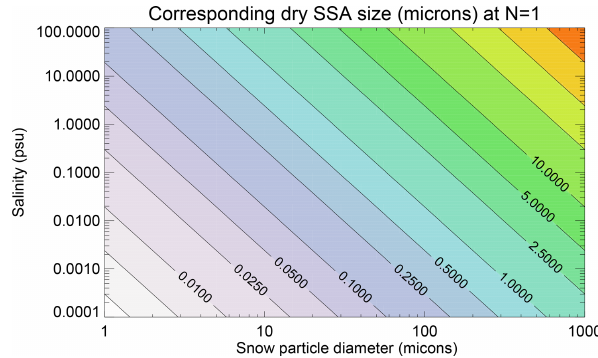
Figure 3. Equivalent dry SSA diameter (µm) as a function of ini- tial snow particle diameter (µm) and snow salinity (psu) at N = 1, calculated following Eq.